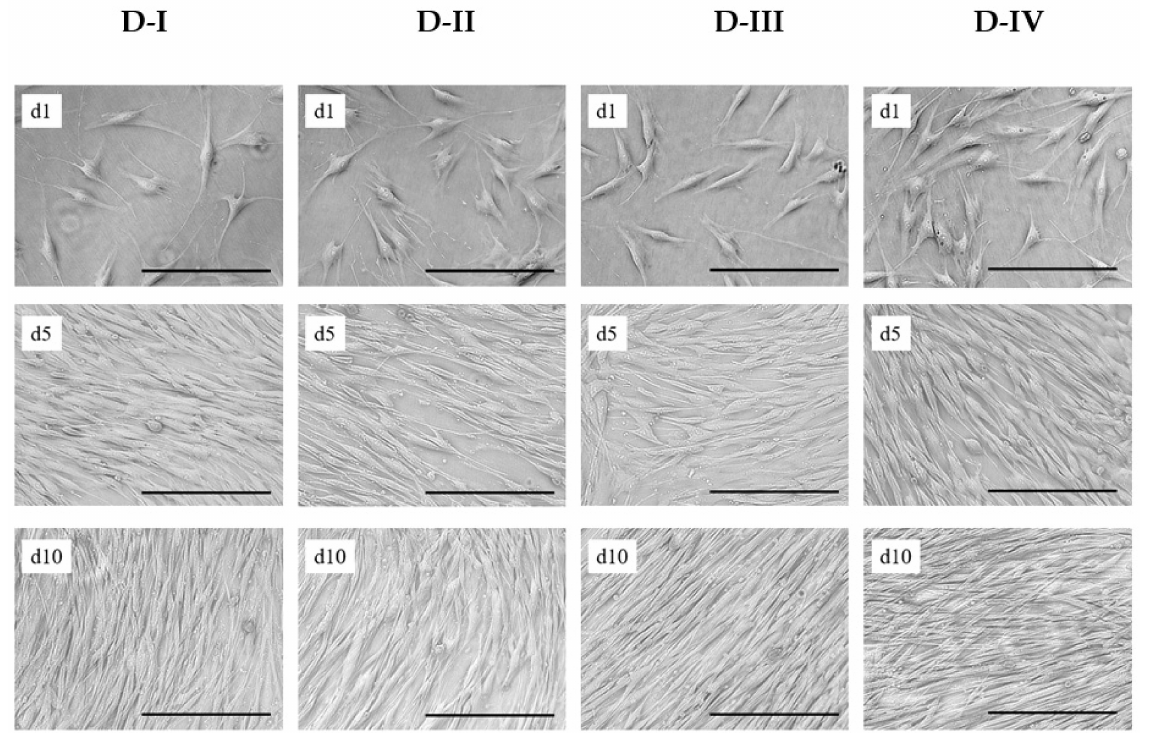
Figure 3. Light microscopic pictures of patient-derived hASCs during cell growth in T25-flasks. Scale bar = 275 µ m. d1 = after cell attachment, d5 = nearly fully confluent, d10 =